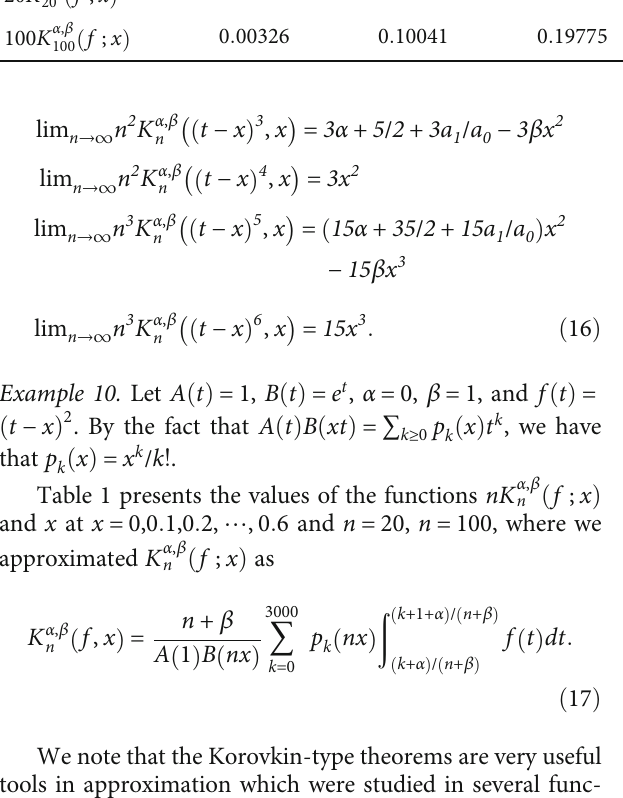
Table 1: The values of the functions 20 K α , β